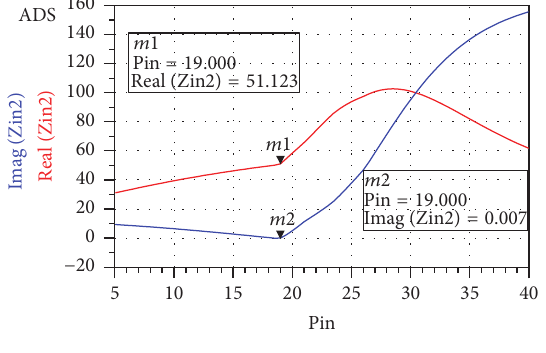
Figure 12: Efficiency of SBS.